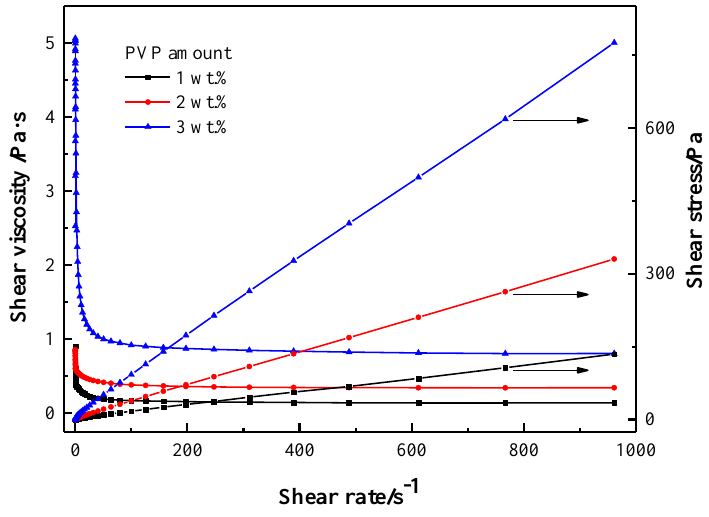
Figure 3. E ff ects of the PVP dispersant amount on the rheological properties of the TiH 2 / Al Figure 3. Effects of the PVP dispersant amount on the rheological properties of the TiH 2 /Al slurries.